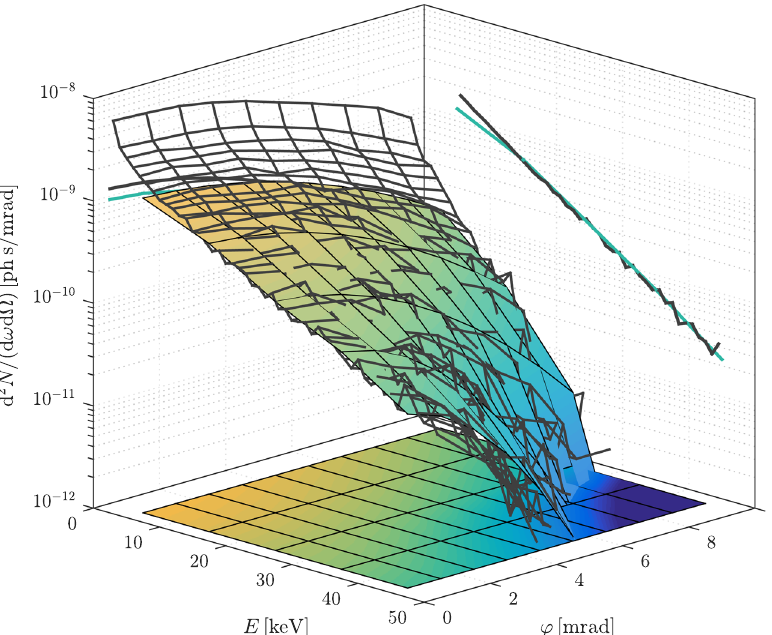
FIG. 7. Comparison of the angularly resolved spectrum retrieved by XCERP diffraction (colored surface) with that of an input beam with the parameters as in Fig. 6 (gray mesh). The side panels show the angularly resolved spectra integrated over energy (left) and angle (right) for the retrieved (blue line) and input (gray line) spectrum. The integrated spectra have been scaled so that they can be displayed on the same z